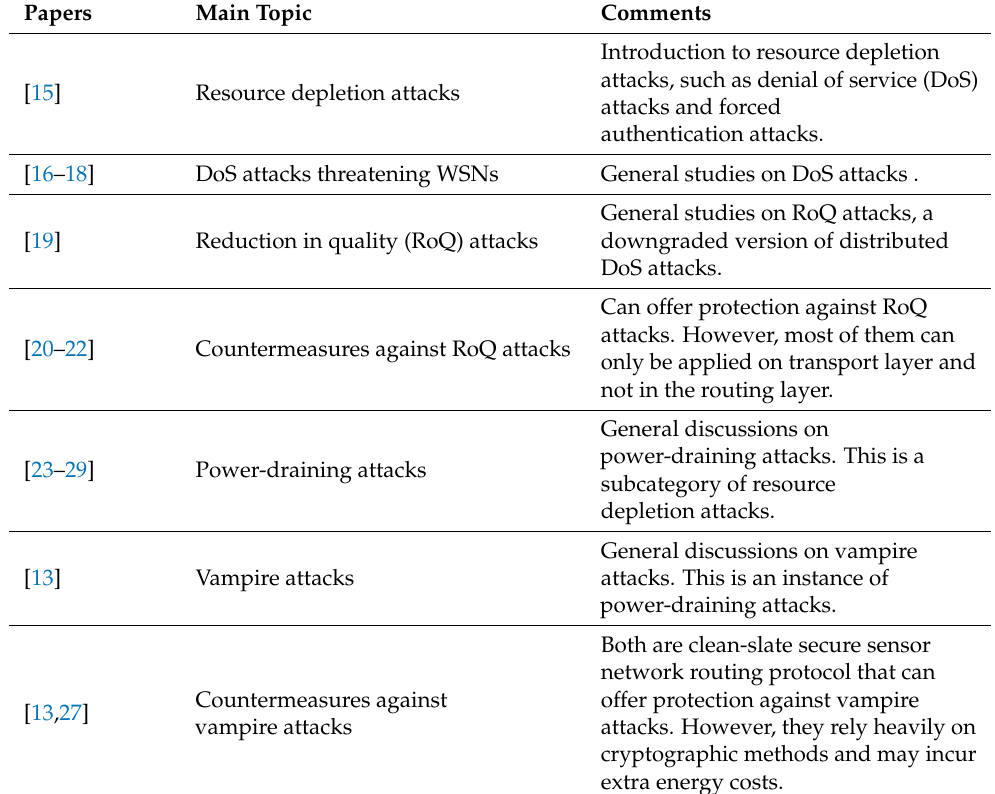
Table 1. Summary of Related